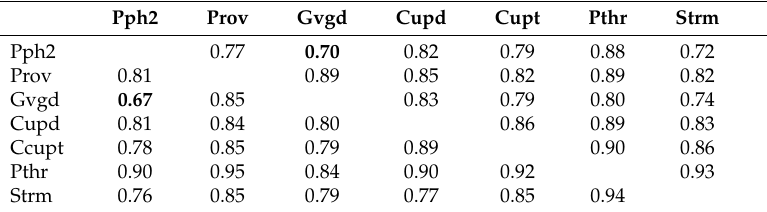
Table 2. The inner consistency between pairs of p-tools measured by the K strong index set to work with a 5% percentage equality threshold. The elements above the diagonal correspond to the BRCA1-SGE dataset while the elements below it correspond to the BRCA1-HDR dataset. Pph2